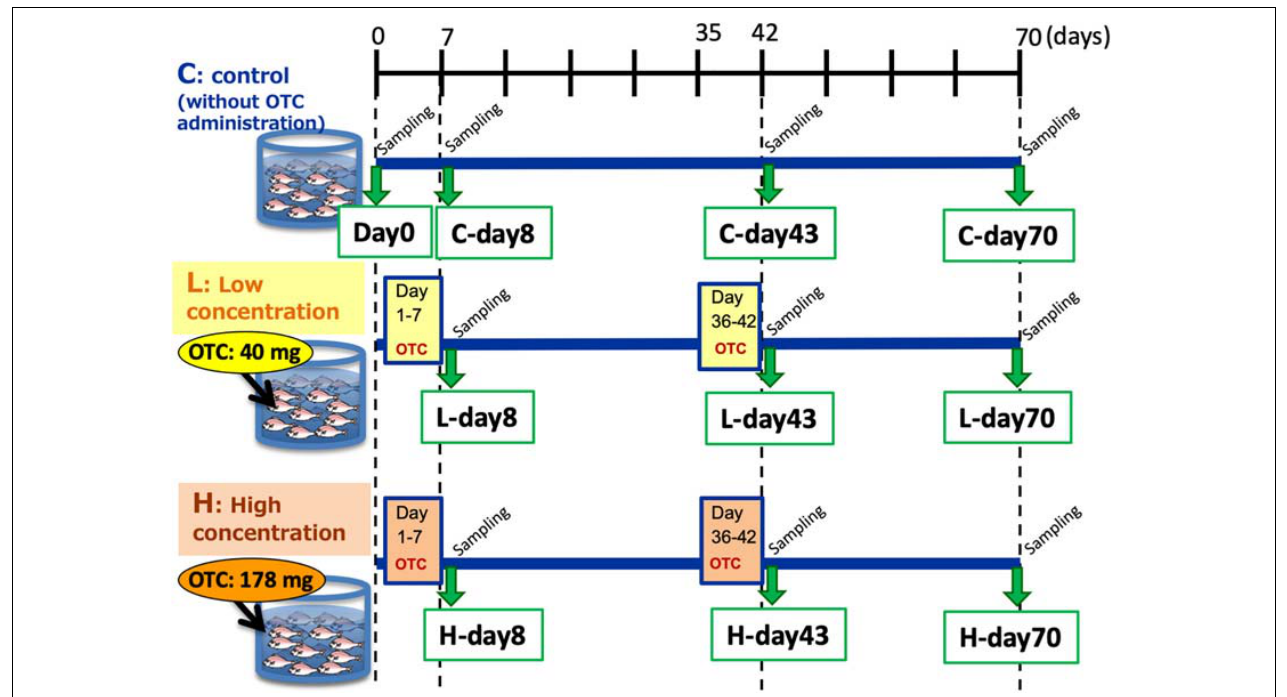
FIGURE 1 | Experimental groups and sampling